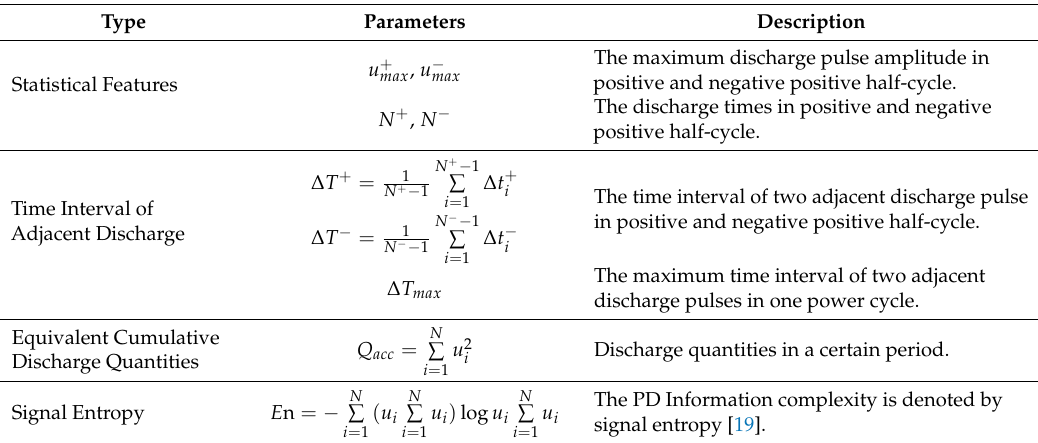
Table 3. Statistical features based on theoretical